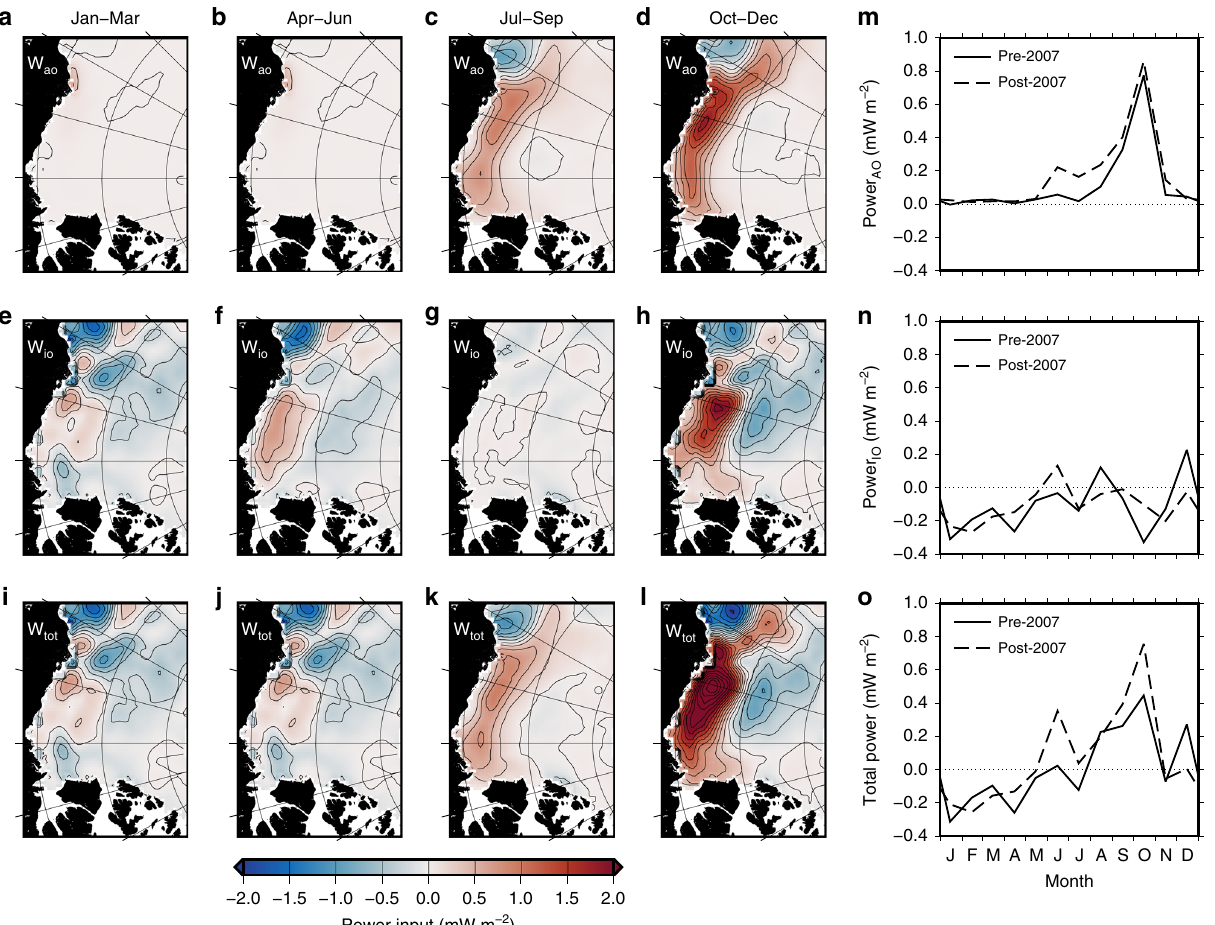
Fig. 3 Seasonal wind energy input to the Beaufort Gyre. Seasonal climatologies of the atmosphere-ocean ( a – d ), ice – ocean ( e – h ), and total ( i – l ) wind energy input for winter (January – March), spring (April – May), summer (June – September), and autumn (October – December), as well as the mean seasonal cycles ( m – o ) before and after 2007.